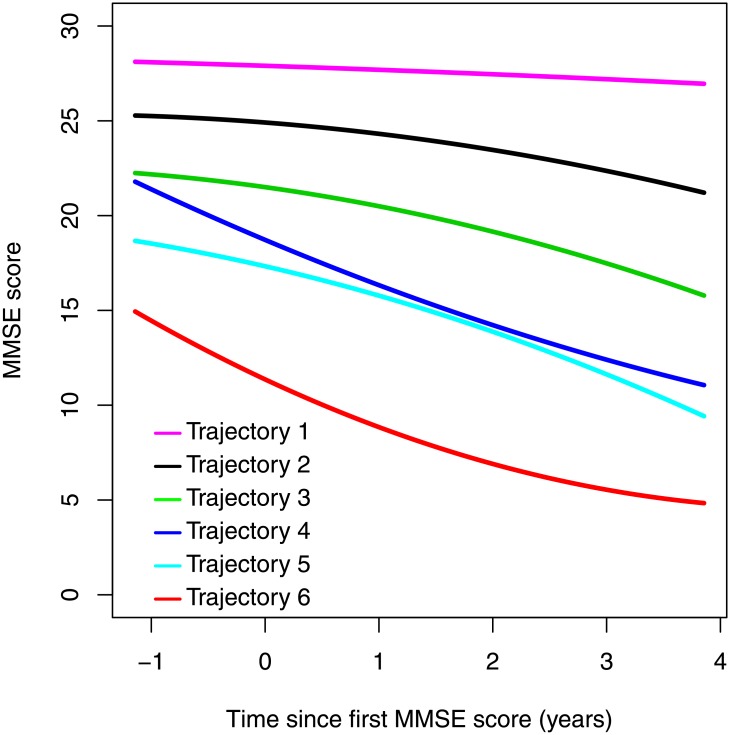
Six trajectories optimally explain the heterogeneity in cognitive decline in this SLaM NHS Trust patient sample with at least three MMSE scores.The trajectories show trend of lower initial baseline MMSE score and faster rate of decline. Trajectory 4 is distinct in that is has a similar baseline MMSE score to trajectory 3 but a similar rate to that of trajectory 6.